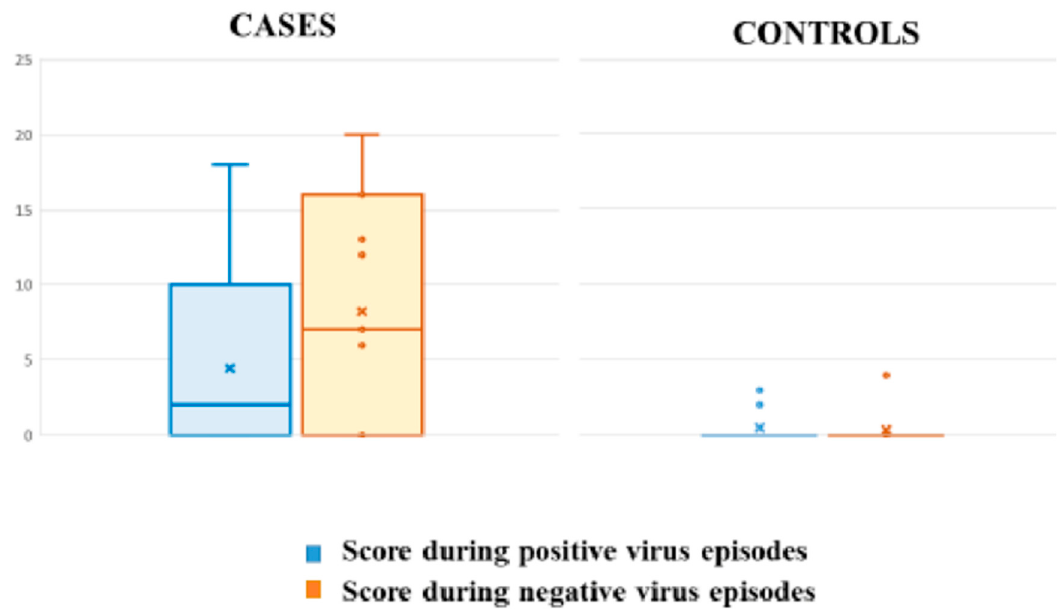
Figure 2. Score obtained from the symptoms questionnaire during positive and negative virus episodes in cases and controls. Box plots show minimum, maximum, median, and Q1 and Q3 questionnaire scores.